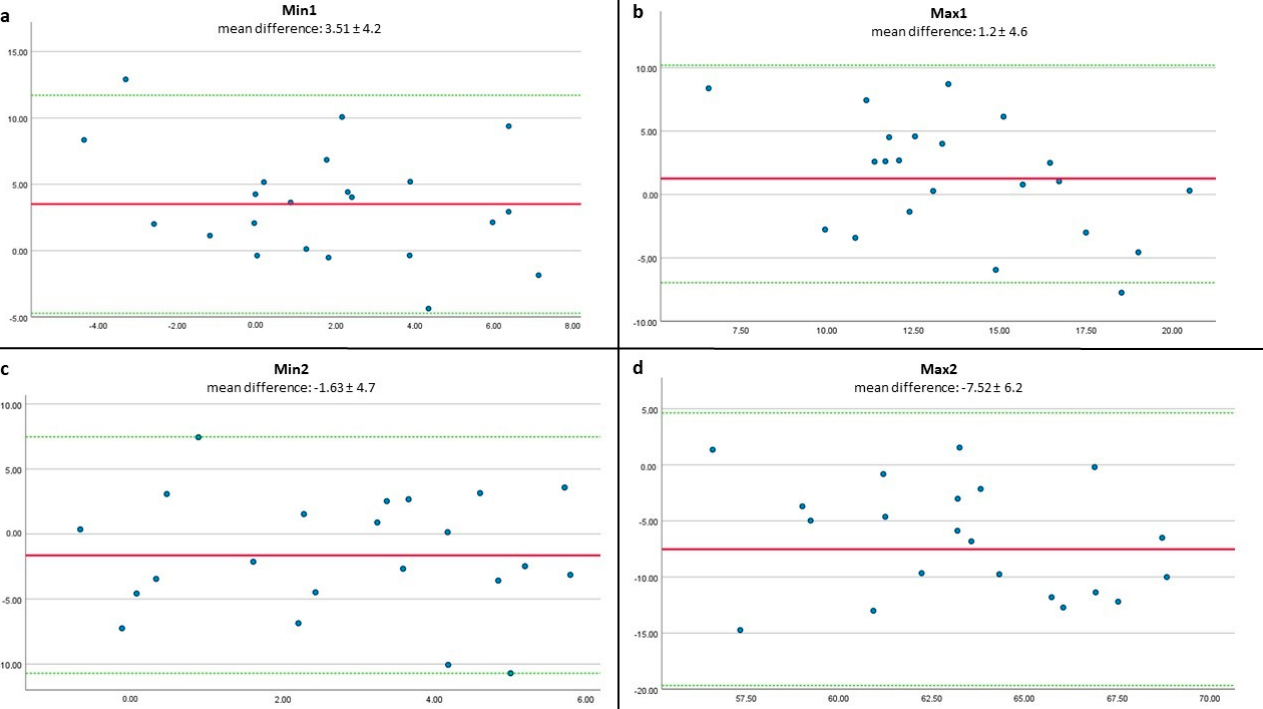
Figure 5. Bland–Altmann Plots x-axis = mean of methods in degree (°), y-axis = difference between both methods in degree (°). The solid line indicates the mean difference (bias) and the dotted lines indicate the limits of agreement for ( a ) Min 1, ( b ) Max 1, ( c ) Min 2, and ( d ) Max 2.